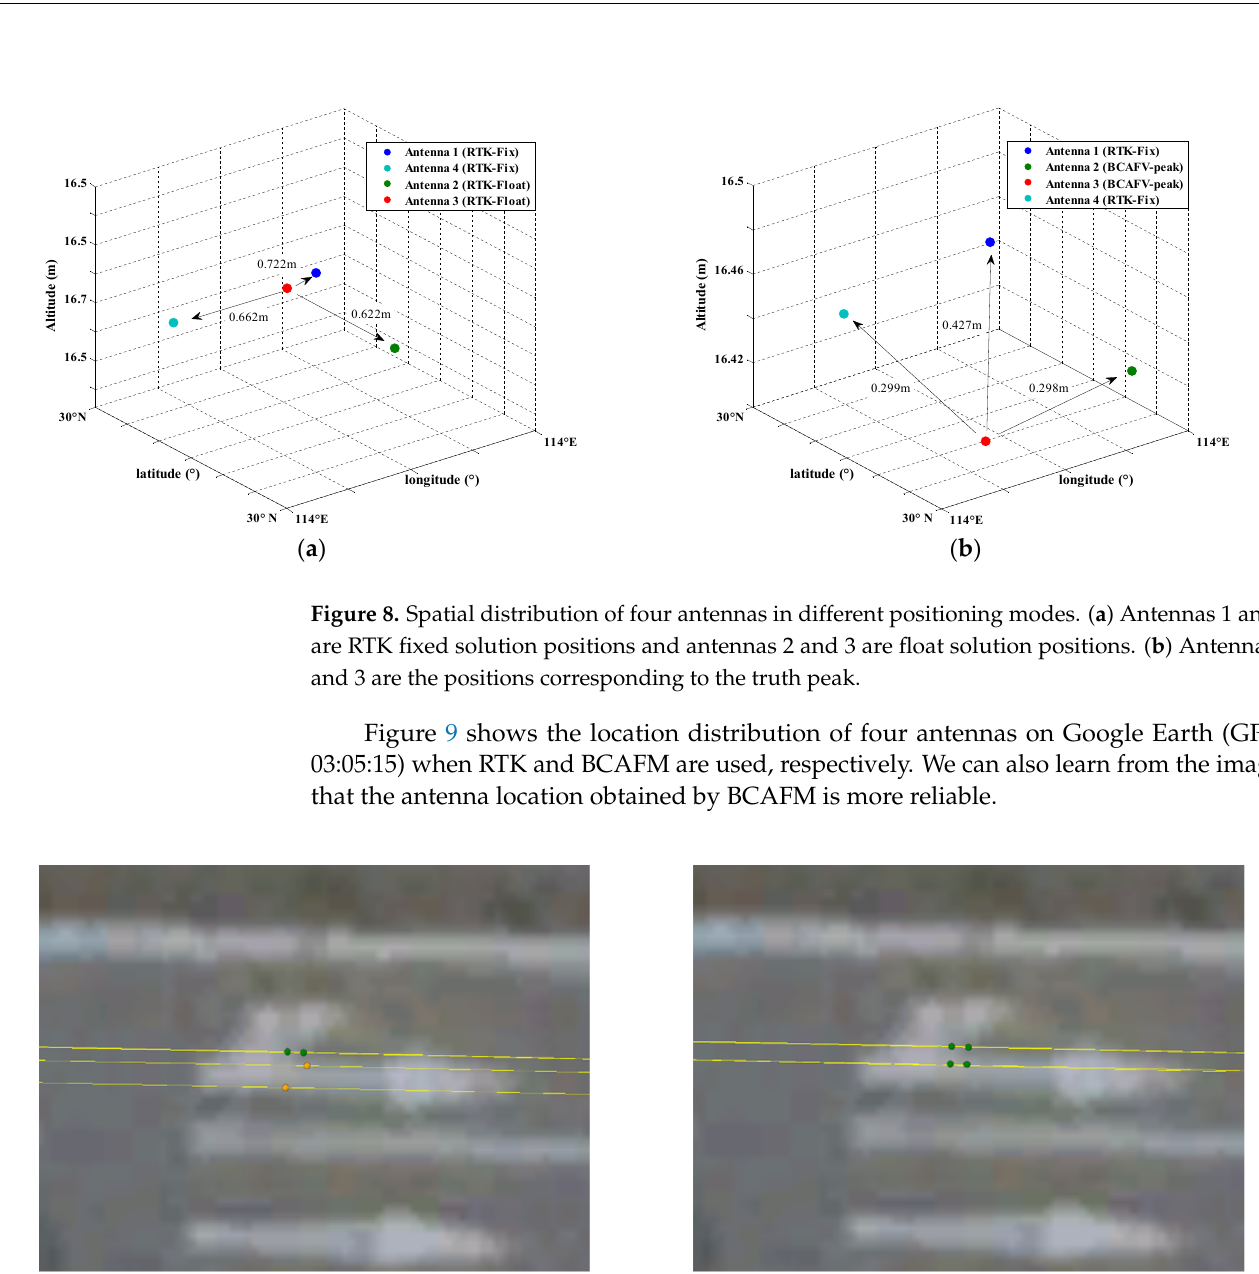
Figure 9. Distribution of four antennas on Google Earth (GPST 03:05:15): ( a ) Result of RTK; ( b ) Result of BCAFM.